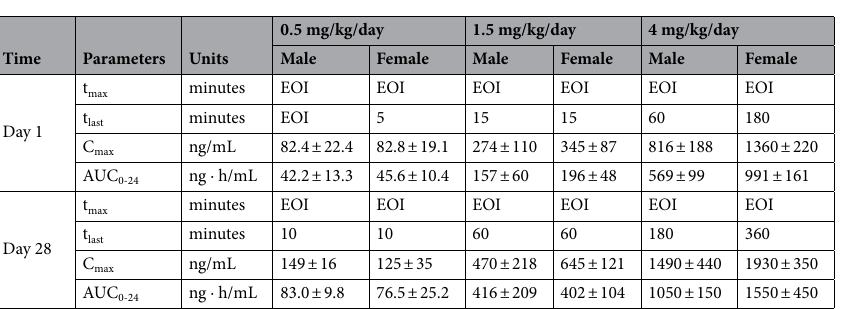
Figure 3. Mean plasma concentrations of SET-M33 on day 1 ( A ) and ( C ) and day 28 ( B ) and ( D ) of 4 weeks of daily intravenous (infusion) administration to male ( A ) and ( B ) and female ( C ) and ( D ) dogs at 0.5, 1.5 and 4.0 mg/kg/day. Symbols (circle, triangle or square) indicate a group mean value. Bars represent standard deviations. The graphs were plotted using GraphPad Prism for Windows version 5.03, GraphPad Software, San Diego, California USA, www. graph pad. com.